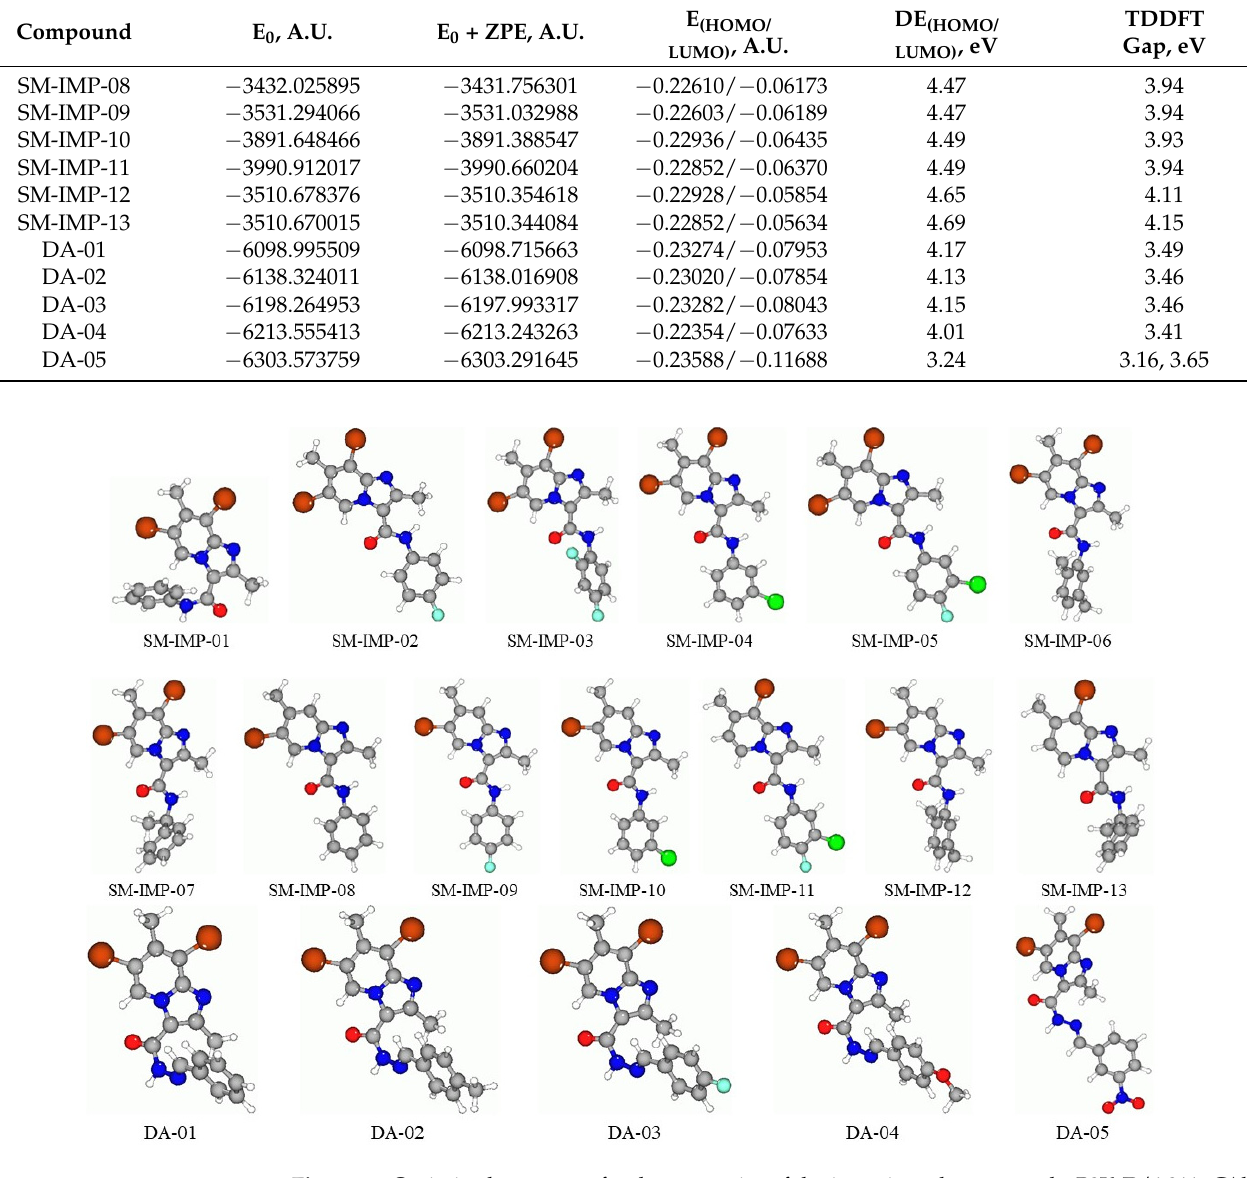
Figure 1. Optimized structures for the two series of the investigated compounds, B3LYP/6-311+G(d,p), with implicit effects from water.